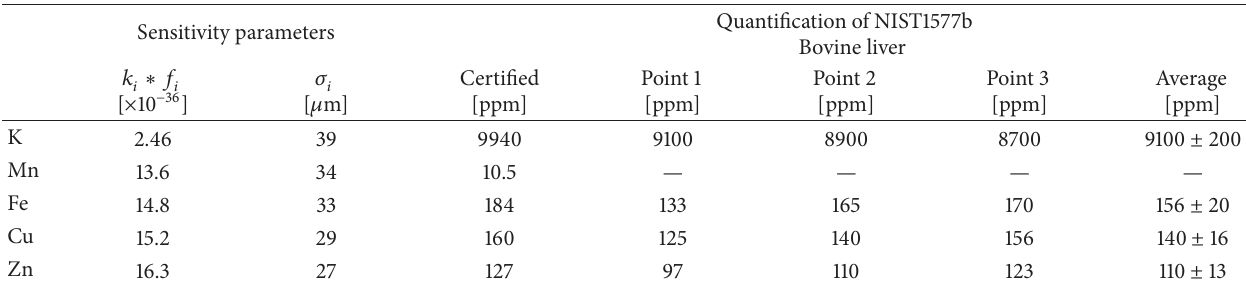
Table 1: Sensitivity parameters and validation of the